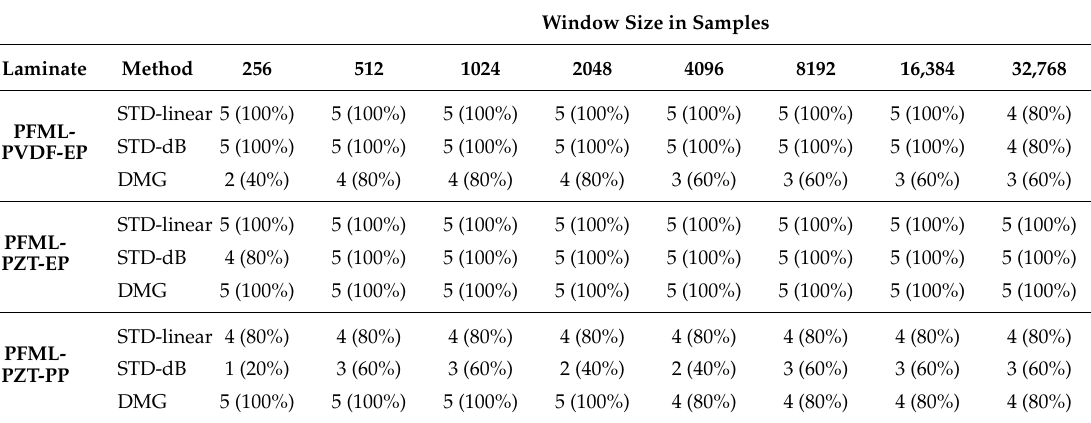
Table 5. Analysis results for complete failure detection by the standard deviation of the SED (STD) and the damage index (DMG) as a function of scaling and measuring window size for the amount of specimens (numbers in brakes show the retaliative quantity of